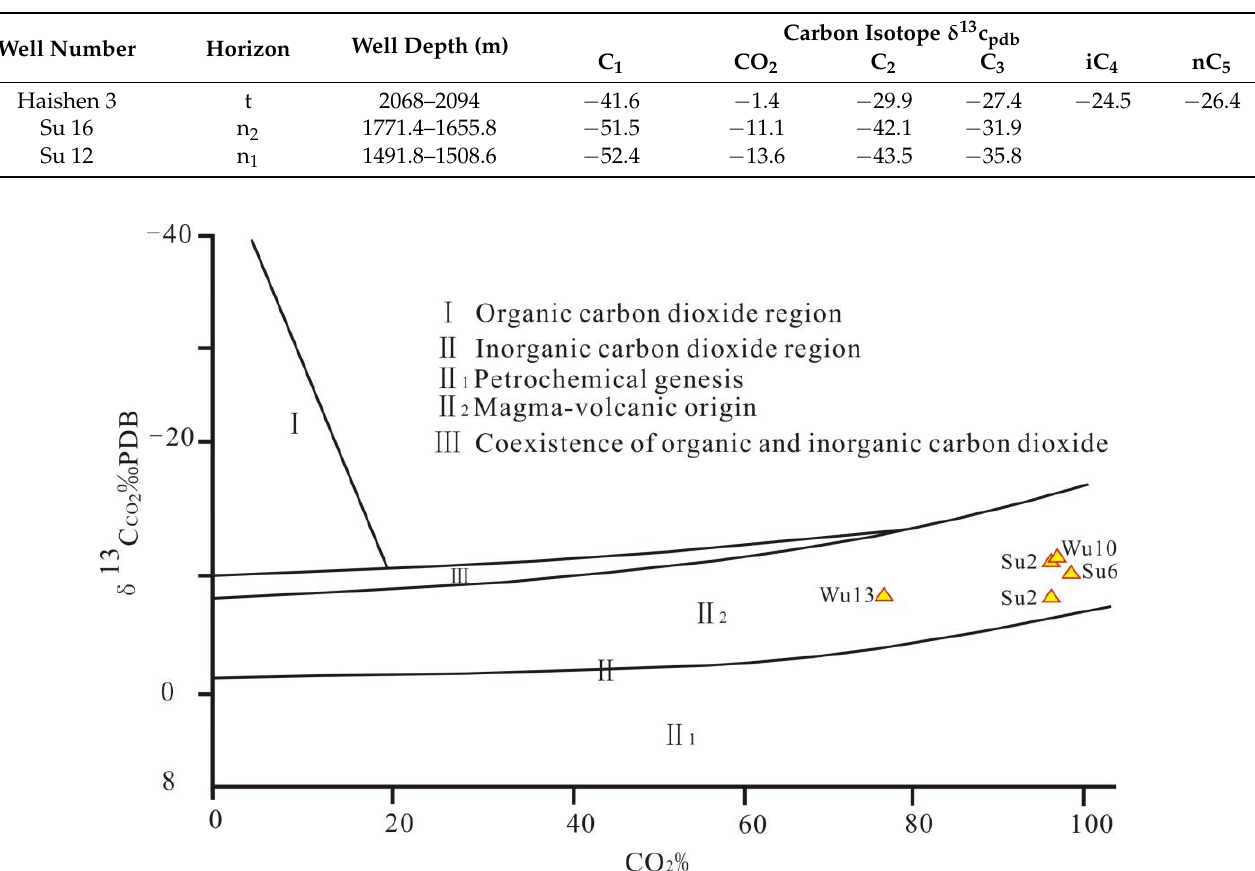
Table 2. The natural gas methane and series isotope test result in Hailar Basin.